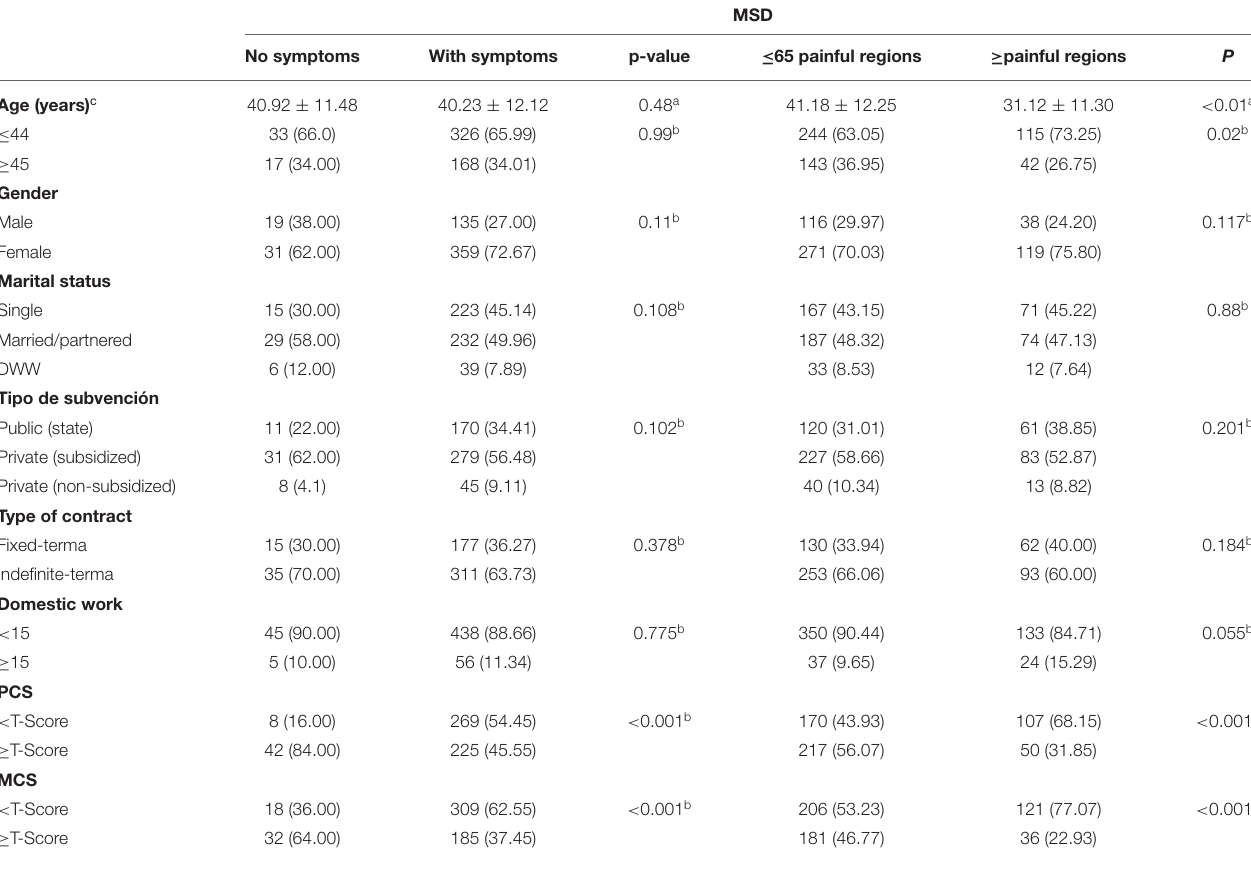
TABLE 2 | Sociodemographic characteristics and quality of life, evaluated by the presence of musculoskeletal disorders in Chilean teachers. MSD No symptoms With symptoms p-value ≤ 65 painful